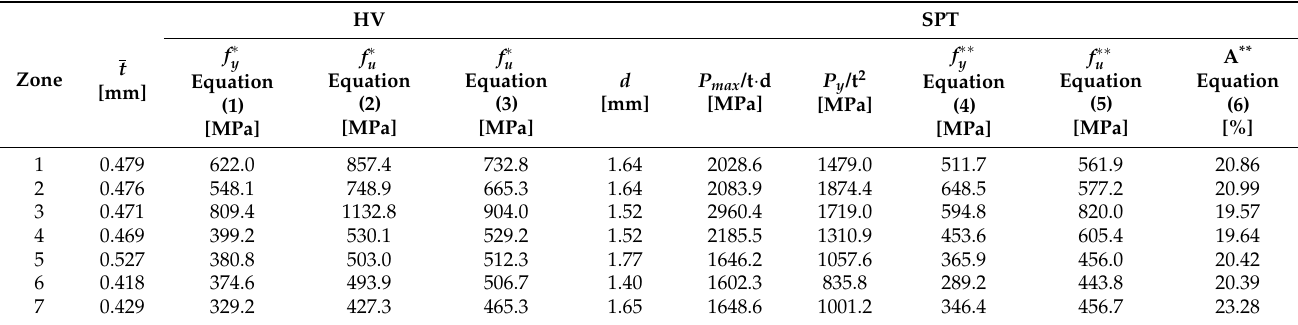
Table 8. Thickness, SPT results, and estimated properties through HV (*) and SPT (**) of the T8 M20 K800 specimen.